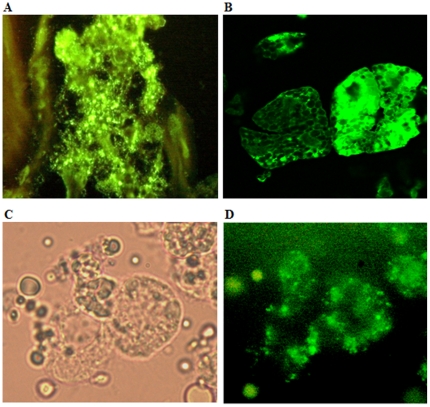
Photomicrographs of LVS colonization of tick gut, salivary glands and hemolymph.(A) Immunostained sections of adult tick gut colonized with LVS. (B) Immunostained sections of colonized adult tick salivary gland acini. (C) Overlapped image of tick hemocytes colonized with GFP expressing LVS. (D) Fluorescent image of the same tick hemocytes. (400× magnification).